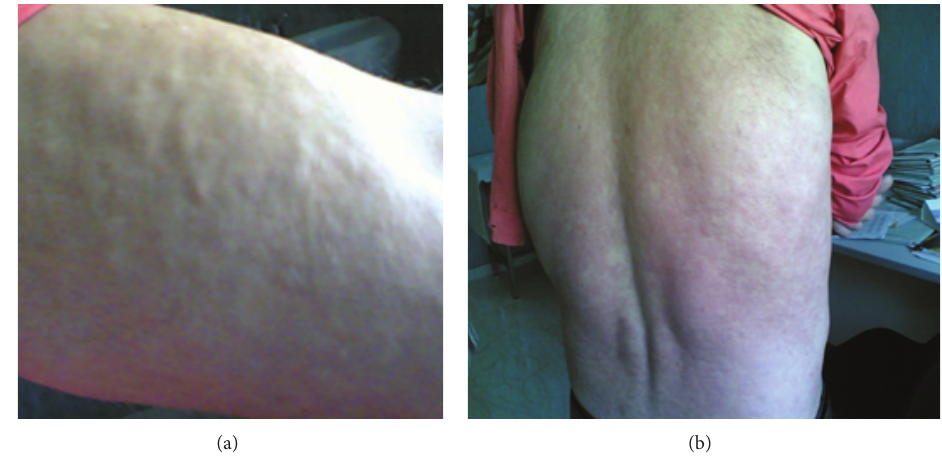
Figure 1: Diffuse maculopapular and nodular rash on the upper limbs (a) and trunk